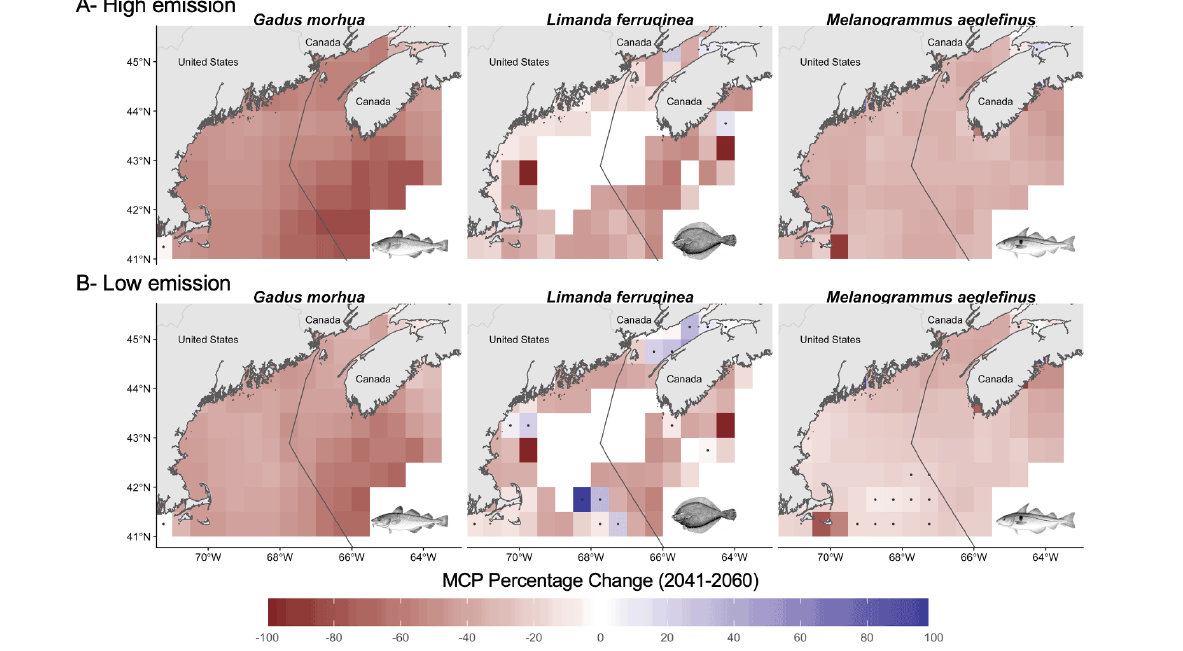
Fig. 4 . Percentage change of maximum catch potential (MCP) in the Gulf of Maine under (A) high emission scenario and (B) low emission for midcentury (2041–2060) relative to the present (2005–2014). Values represent the mean of three Earth system models (ESMs). Points represent regions where ESMs do not agree in direction of